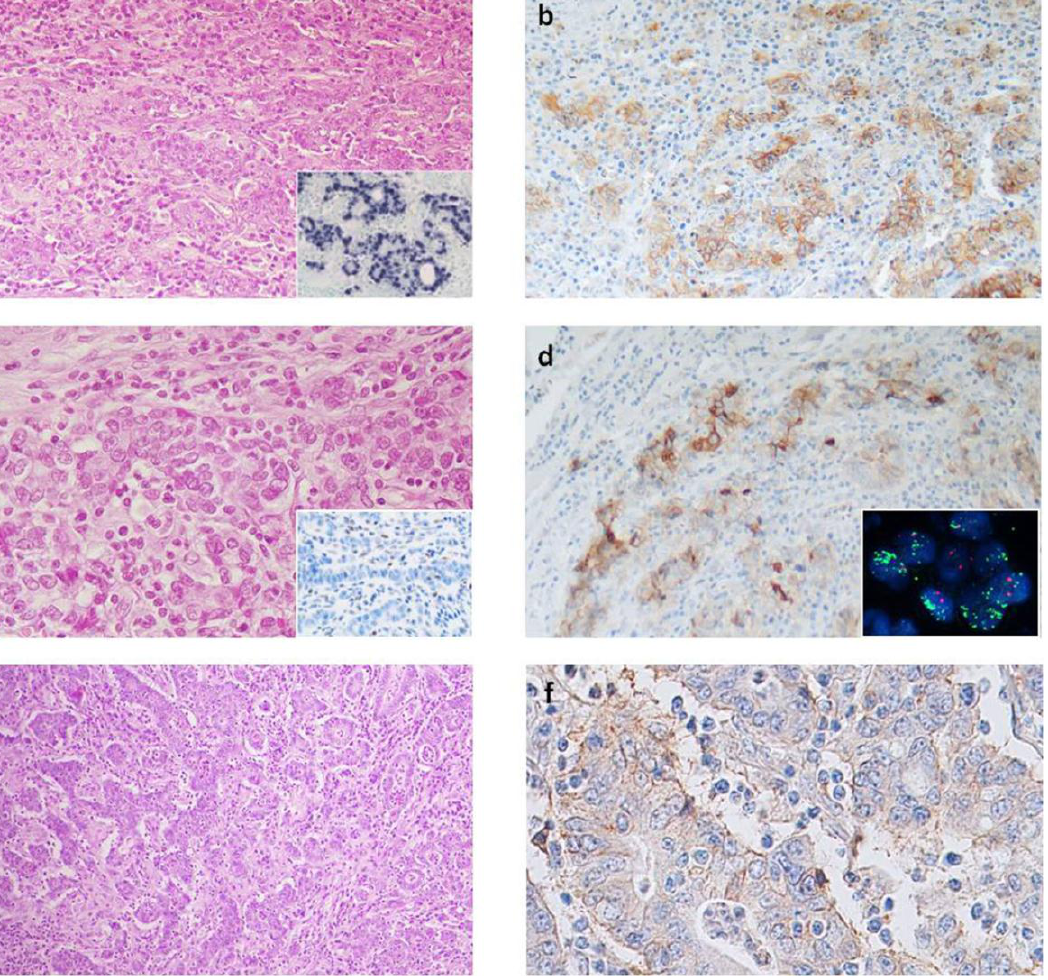
Figure 1. ( a ) EBV+ gastric carcinoma showing lymphoid stroma and ( b ) abundant PD-L1+ tumor cells spread out along the tumor; ( a inset ), in situ hybridization for EBV RNA, EBER; ( c ) The MSI gastric cancer lacking MSH2 protein ( c inset ); with ( d ) intense PD-L1 expression prevalently along the infiltration front and ( d inset ) high levels of PD-L1 gene amplification; ( e ) One of the MSS/EBV − gastric carcinoma showing abundant lymphocytes infiltration and ( f ) weak PD-L1 immunoreactivity along membrane of tumor cells. Original magnification: a, b, d, e, a inset and c inset, 100×; c, 200×; f, 400×; d inset, 1000×.